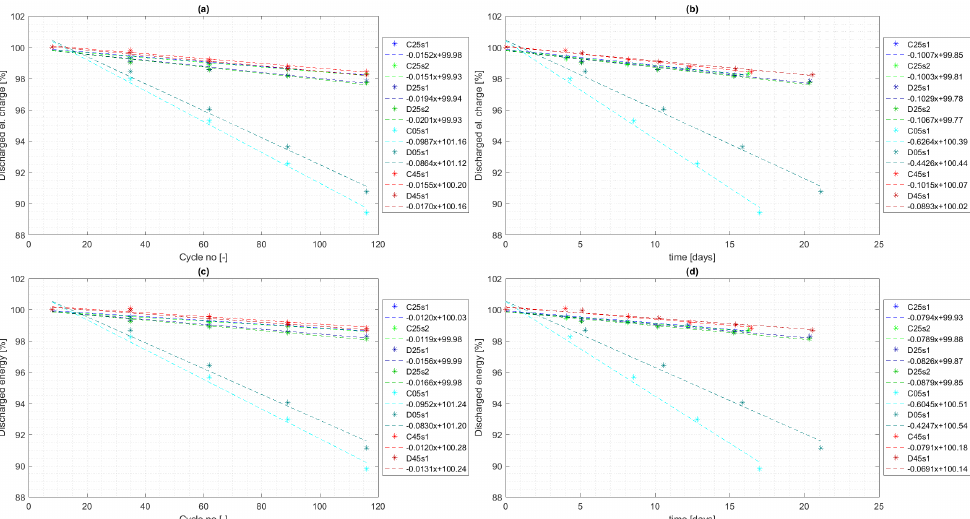
Figure 15. Capacity fade and energy decrease measured and regressed for all cycle aging cells for all the second of the two consecutive capacity test cycles depending on cycle no. and time. All the values are normalized to the second cycle of the first two consecutive capacity tests (cycle no. 8), so that this value is equal to 100%.